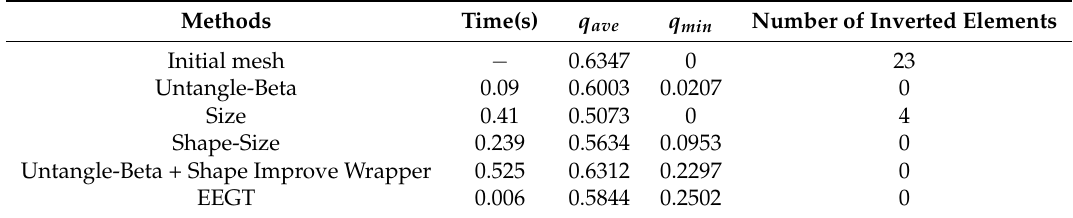
Table 1. Mesh quality statistics and the number of inverted elements for quadrilateral mesh example. The mean ratio quality metric is used to measure the mesh